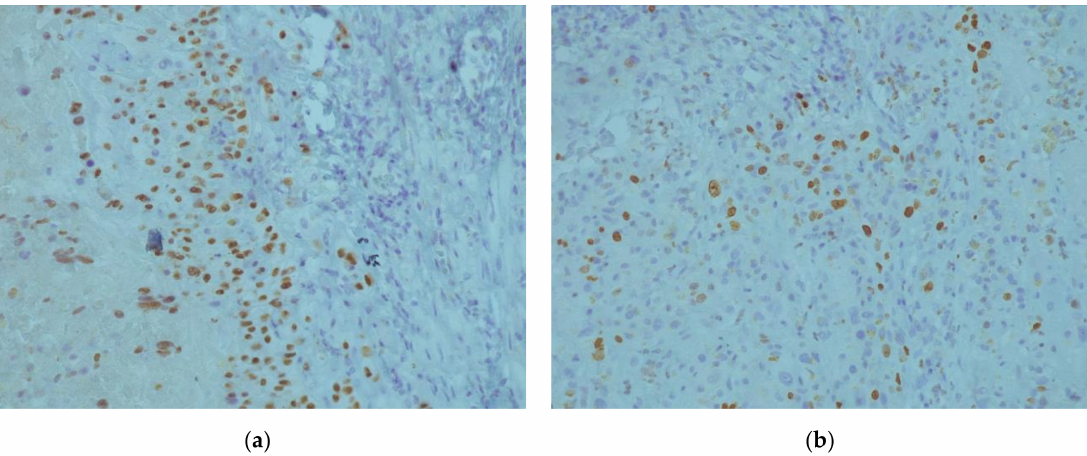
Figure 2. Immunohistochemical exam of the sample: ( a ) Diffuse strong positivity for CK AE1/AE3; ( b ) diffuse positivity for Cyclin E.